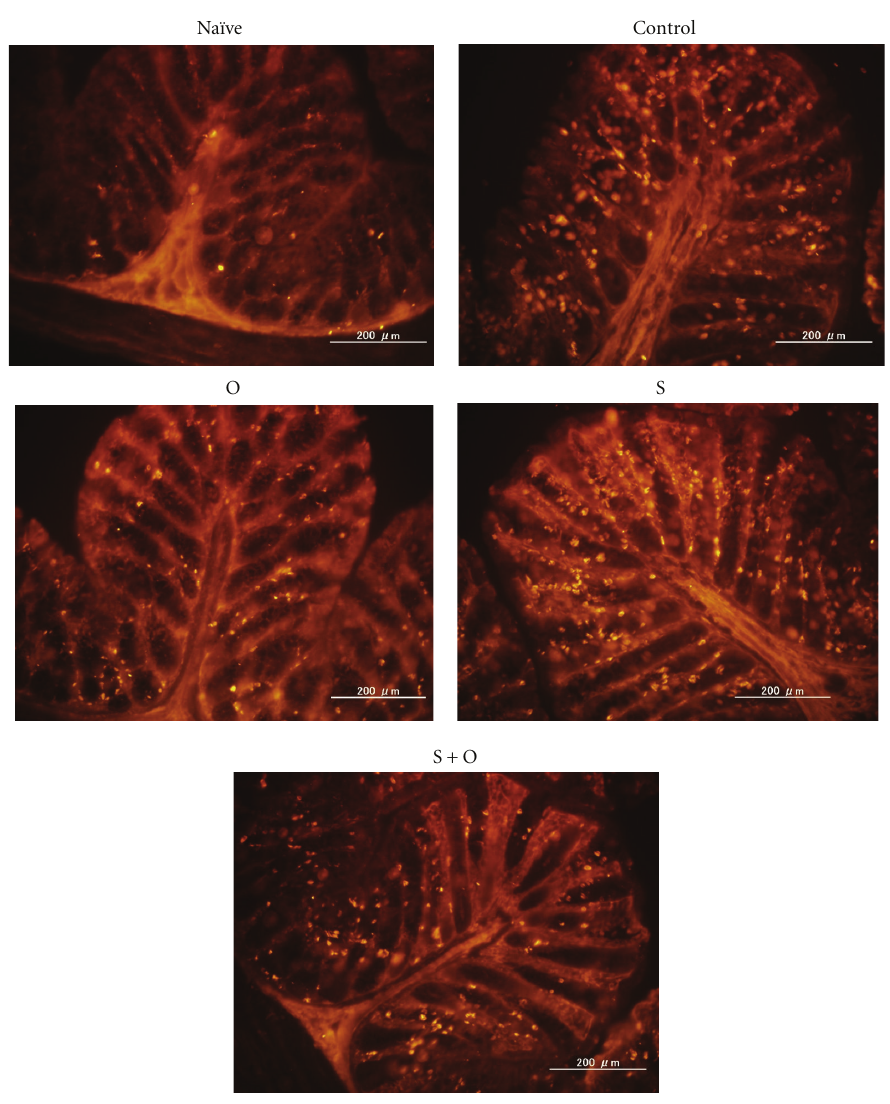
Figure 5: E ff ects of the maternal exposure to food antigens during lactation and the maternal allergic status on mucosal mast cell infiltration in the proximal colons of o ff spring FA. The infiltration of mucosal mast cells was greatly attenuated in o ff spring with FA breastfed by OVA- exposed mothers during